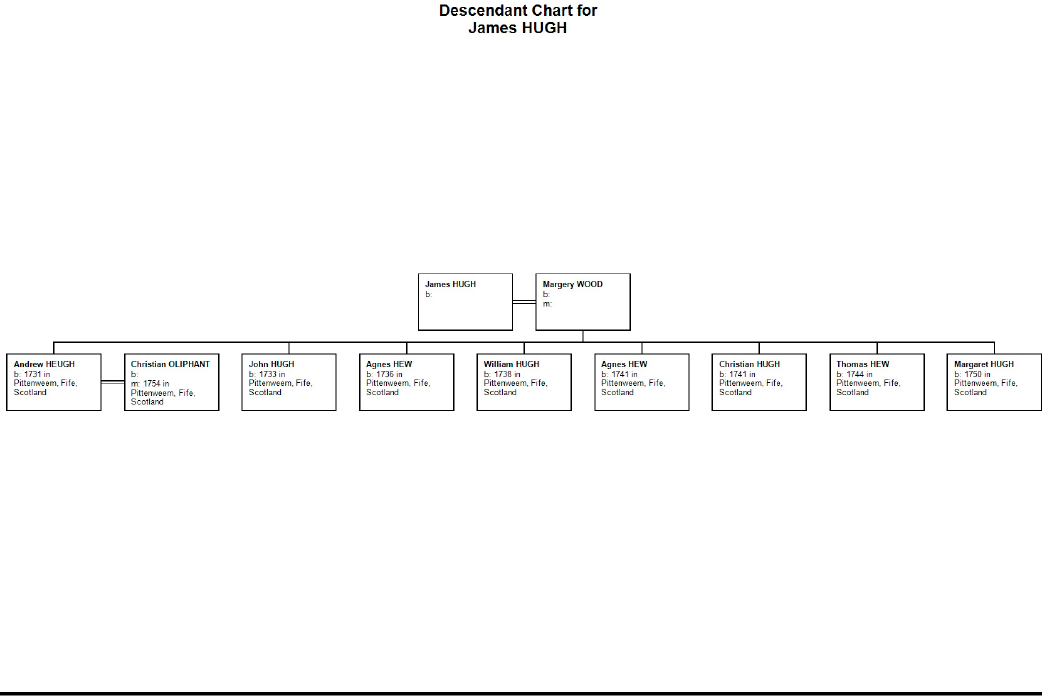
Figure 1. Children of James HUGH and Marjory WOOD.